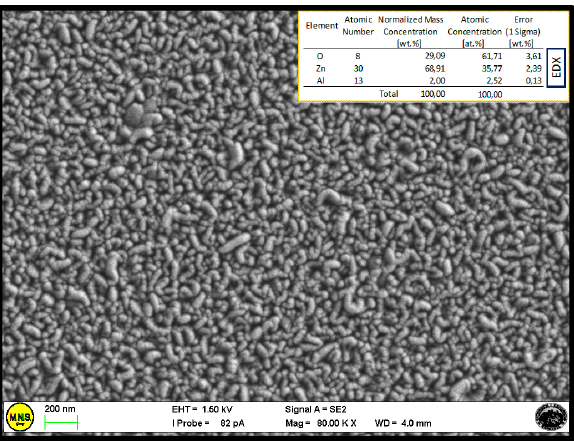
Figure 2. Field emission ‐ scanning electron microscopy (FE ‐ SEM) analysis of the AZO layer deposited by co ‐ sputtering in co ‐ focal geometry at 188 °C. Inset: the atomic percentages of the species revealed by energy dispersive X ‐ ray (EDX) probe.